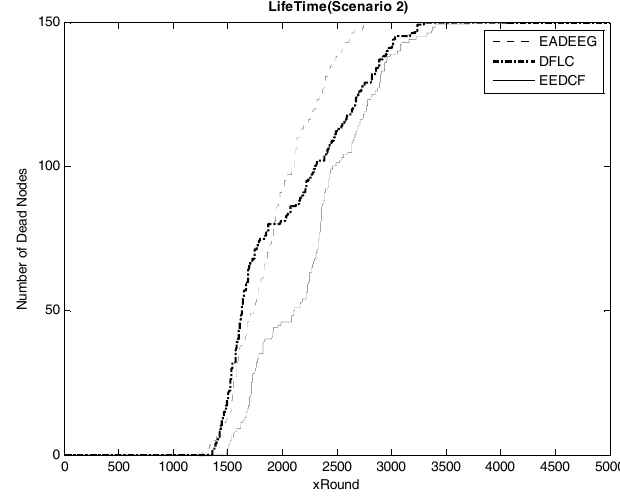
Figure 8. Comparison of network lifetime of the three algorithms in Scenario 2 (The vertical axis denotes the number of dead nodes, and the horizontal axis denotes the round number). Table 4. Death time of nodes in some specific time points in Scenario 1.